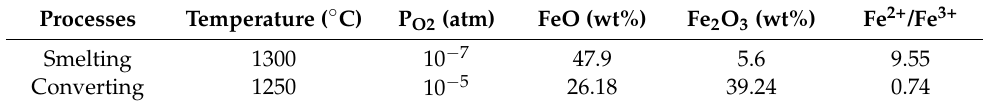
Table 2. Fe 2+ /Fe 3+ ratio in the smelting and converting slags calculated by FactSage 8.2.